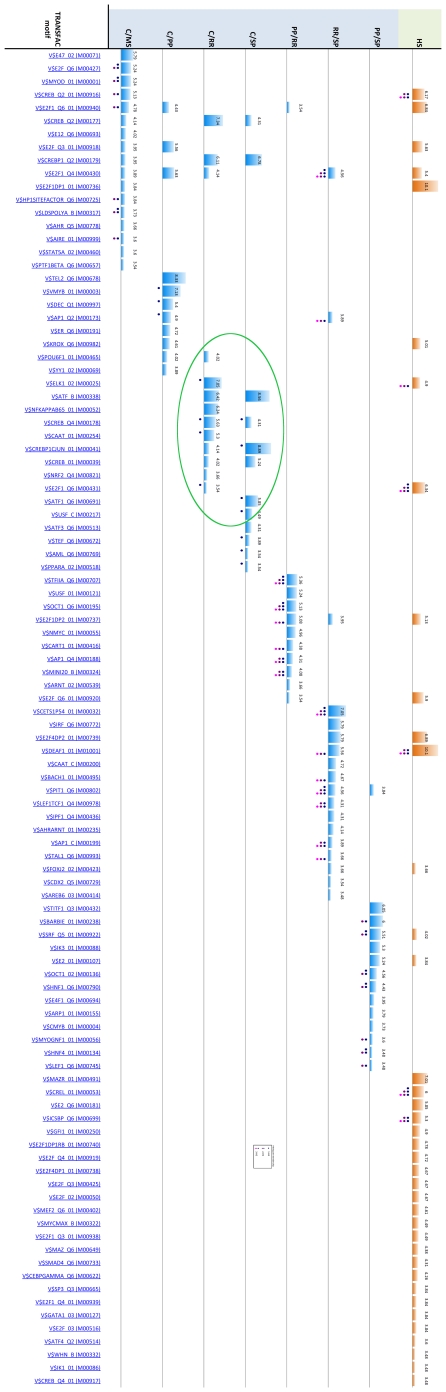
TRANSFAC motif profiles for the seven signatures (blue bars).Only significant motifs (p-value ≤0.05) are shown. Bar size is proportional to the negative natural logarithm of p-value, which is also given as a number. Note that, in contrast to other pairs of profiles, there is a sizeable intersection between the C/RR and C/SP profiles (green ring). “Key” regulators of each profile, which are found by hitting set analysis, are indicated by dots underneath a bar (see figure legend). The TRANSFAC profile for the set containing all the key regulators' coding genes is shown (orange bars); this profile in effect contains “higher level” regulators – i.e. a hierarchy with a next level of putative regulators of regulators.